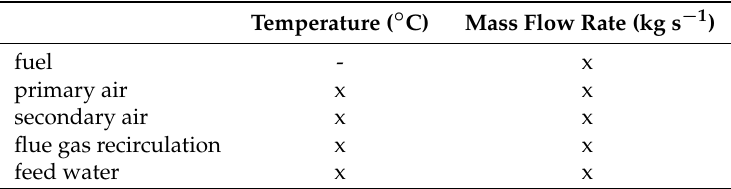
Figure 2. Object-oriented approach, CFB (Circulating fluidized bed) in Dymola, boiler bed and riser ( A , B ), cyclone ( C ), hot solid re-circulation via SH3 in the loop-seal ( D ), SH1 and SH2 ( E ), and the economizer ( F ). Table 1. Process signals used as input into the